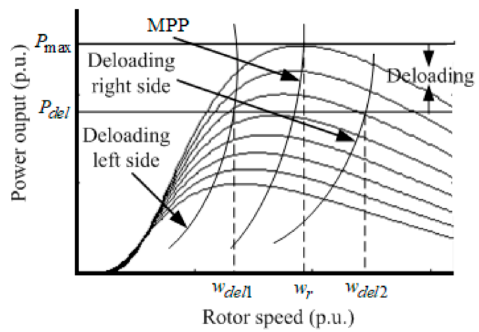
Figure 3. Tidal rotor speed vs power output at different blade pitch angles [24].